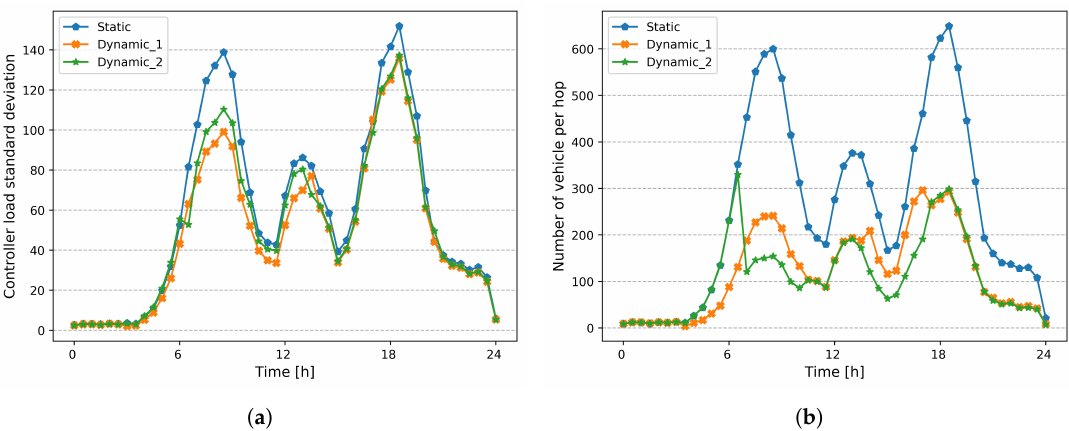
Figure 13. Comparison of Static and dynamic Placement strategies. ( a ) Standard deviation of Controller Load; ( b ) Number of Vehicle at 3